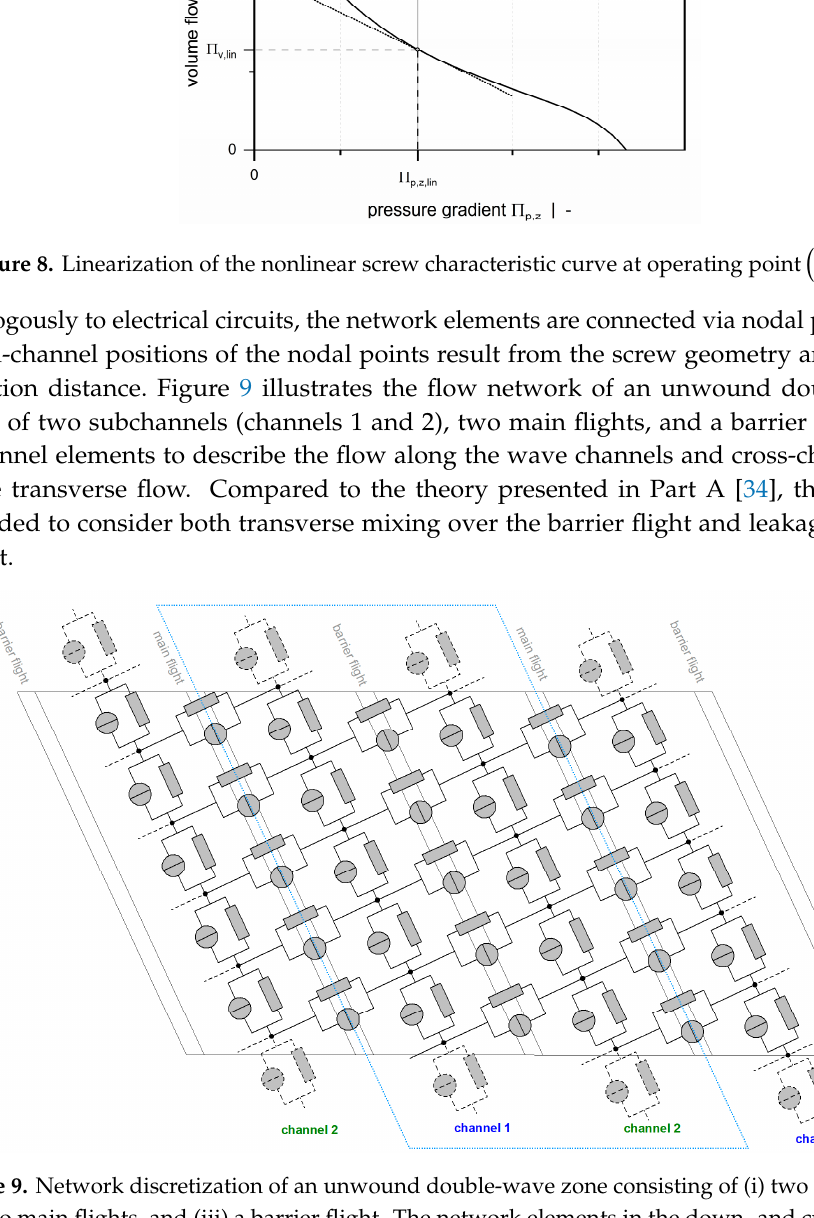
Figure 9. Network discretization of an unwound double-wave zone consisting of (i) two subchannels, (ii) two main flights, and (iii) a barrier flight. The network elements in the down- and cross-channel directions are connected via nodal points.